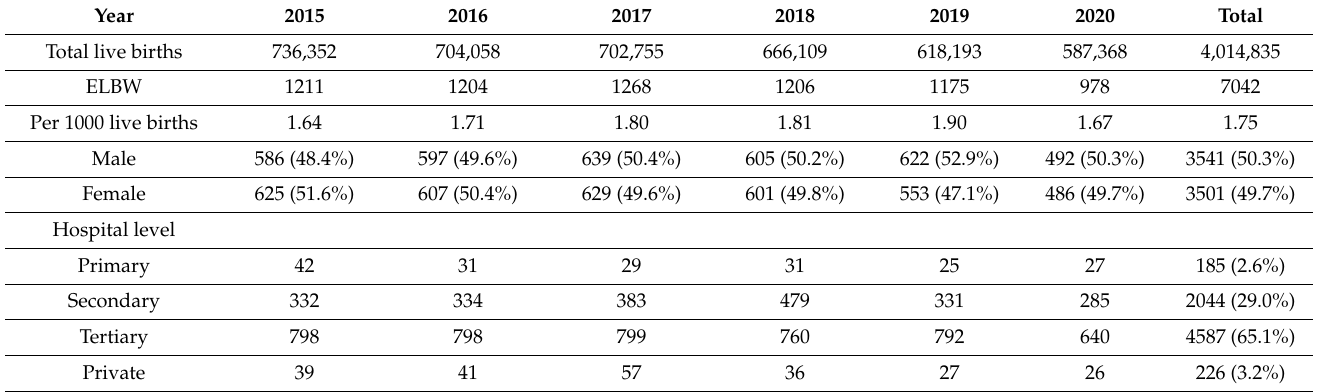
Table 1. Total number of live births and number of extremely low birth weight (ELBW) infants born between 2015 and 2020 classified by year of birth and hospital